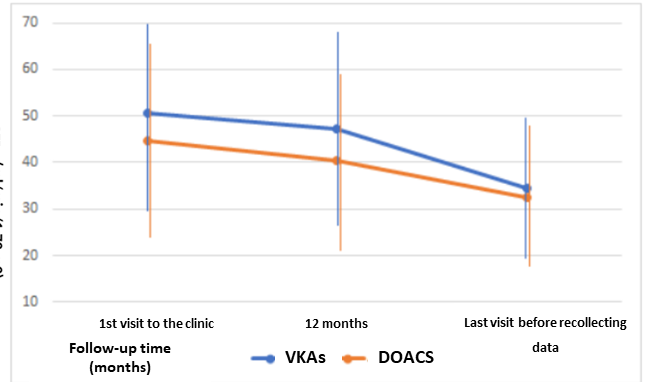
Figure 2. Evolution of renal function depending on the type of anticoagulant: The drop in eGFR in the first year of treatment was greater in the DOAC than VKAs group. However, we did not observe a relationship between anticoagulant type and rate of renal progression throughout follow-up. Ab- breviations: eGFR: estimated glomerular filtration rate. DOACs: direct-acting oral anticoagulants. AVK: vitamin K antagonist anticoagulants.